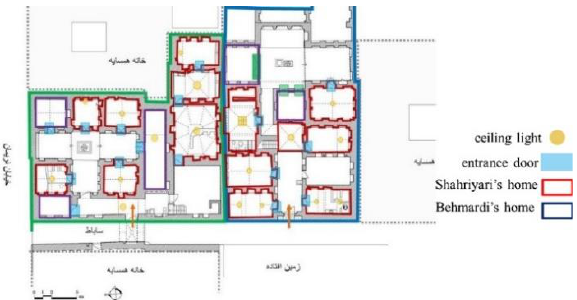
Figure 8: Tow houses for showing: Type and area of opening in the village houses.